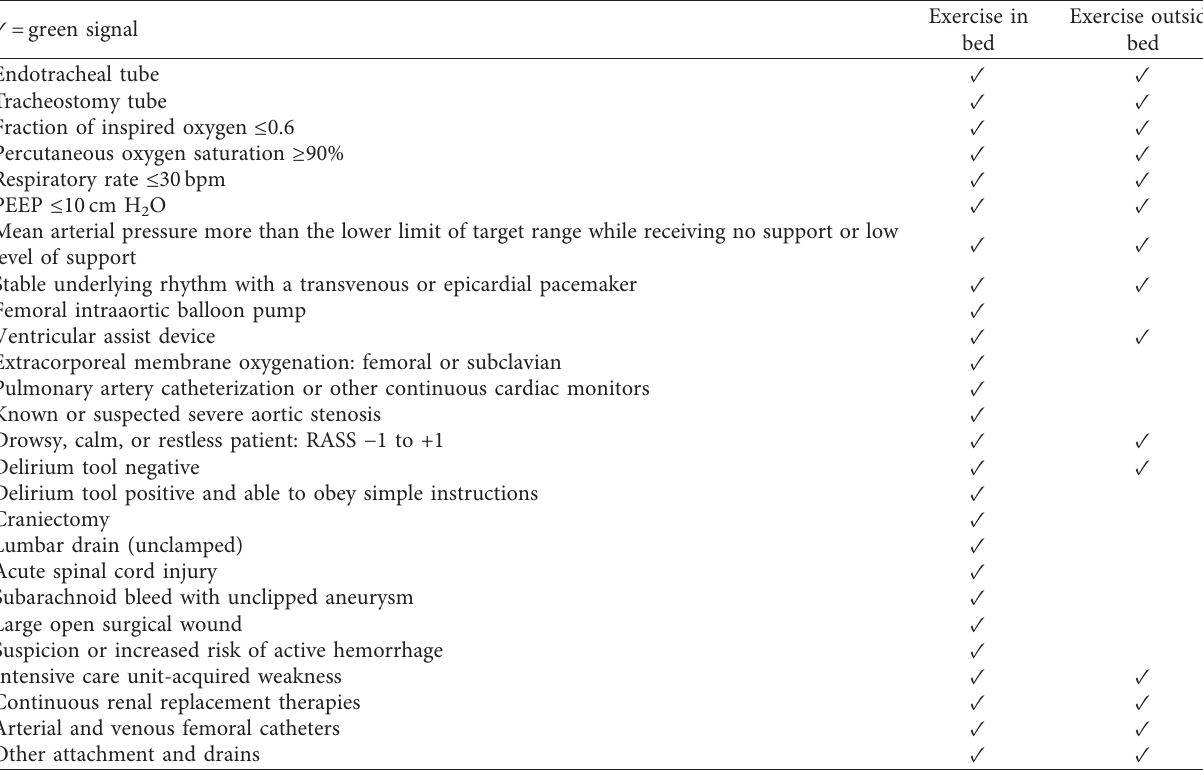
Table 7: Green signals for active mobilization of mechanically ventilated